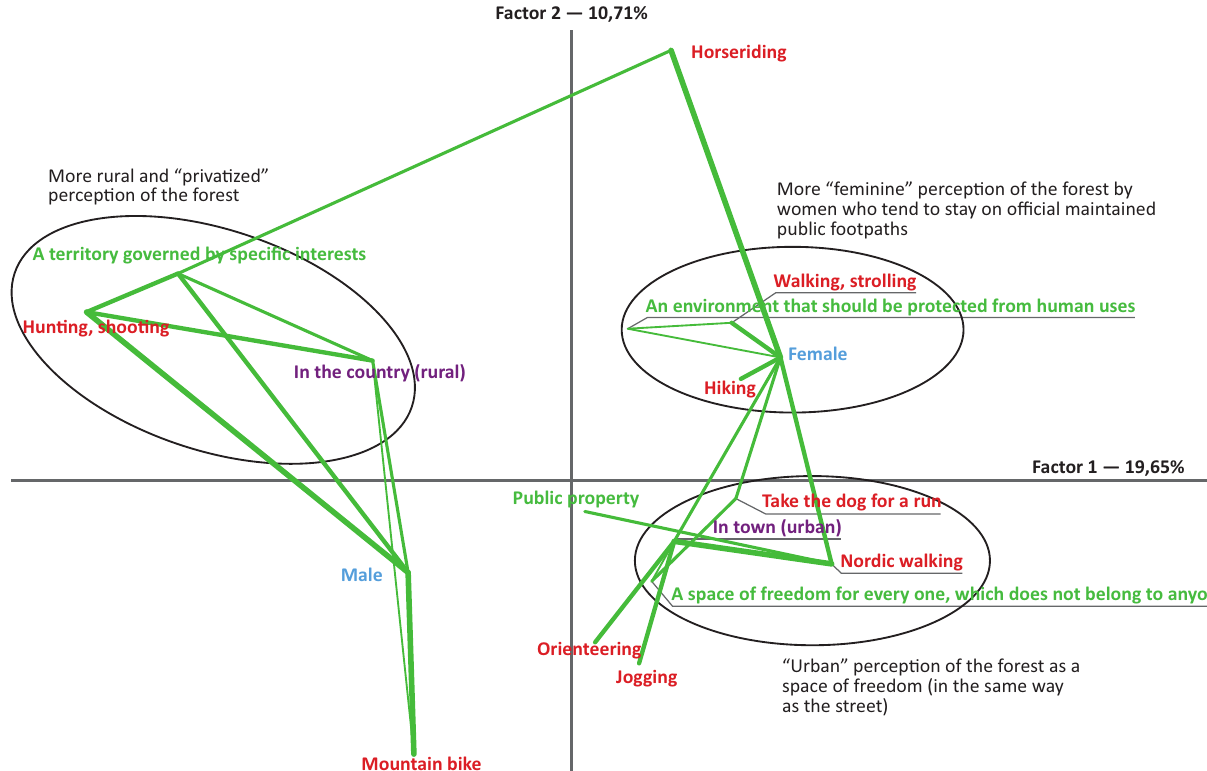
Figure 3. Factor analysis of forest design by gender and type of activity, based on the scope of the global university survey (n =